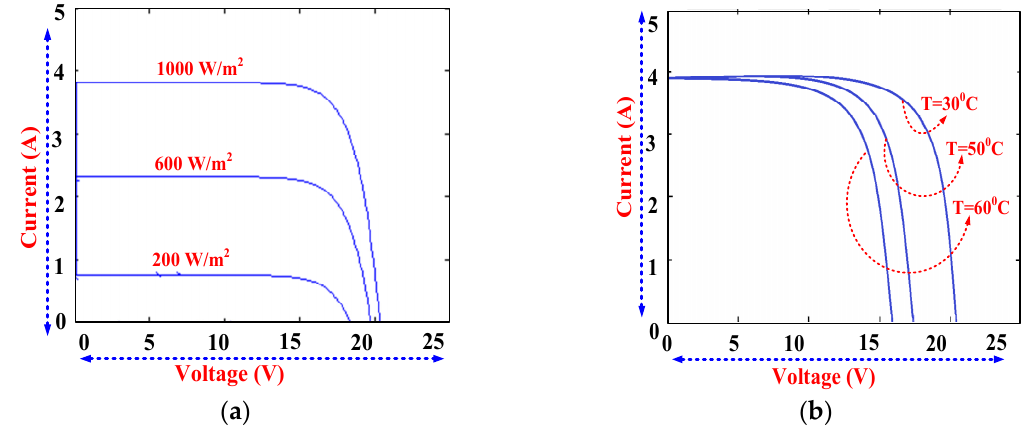
Figure 3. I-V characteristics of MSX 60W PV panel for ( a ) varying irradiance ( b ) varying temperature. Table 1. MSX-60W PV Module Specifications.